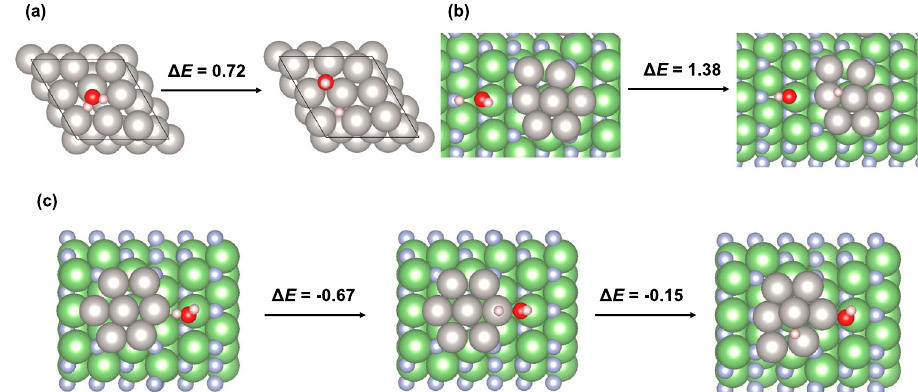
Fig. 3 | Theoretical study of water dissociation. The Pt/GaN interface promotes water splitting. Optimized structures and calculated energy changes of a water dissociation on Pt(111), b proton transfer from surface N – H to a Pt cluster, c water